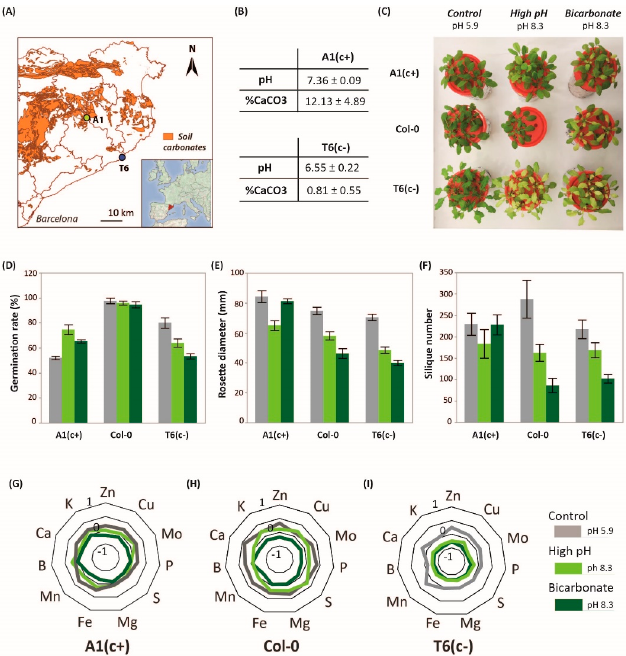
Figure 1. Location, soil parameters, physiological characterization, and plant nutrition. ( A ) Location of Arabidopsis thaliana natural populations A1 (c+) and T6 (c − ) in a soil map of Catalonia. Orange areas represent calcareous soils and white areas non-calcareous soils. ( B ) Soil carbonate and pH levels (means ± Standard Error; n = 9) in the natural habitat of A1 (c+) and T6 (c − ) populations. ( C ) Picture of 30-day-old Col-0, A1 (c+) , and T6 (c − ) plants under different alkaline treatments. Germination rate ( D ), rosette diameter ( E ), and silique number ( F ) of A1 (c+) , T6 (c − ) , and Col-0 plants submitted to control (pH 5.9, grey bars), high pH (pH 8.3, light green bars), or bic (pH 8.3 with 10 mM of NaHCO 3 , dark green bars) in plates or hydroponic culture. Values are means ± SE; n = 45, n = 12, n = 9, respectively; letters indicate significant differences ( p < 0.05, Tukey’s honestly significant difference HSD ) per deme. ( G , H , I ) Standardized leaf mineral content of four plants per deme grown under pH 5.9 (grey lines), pH 8.3 (light green lines), or bic (dark green lines) for 2 weeks.